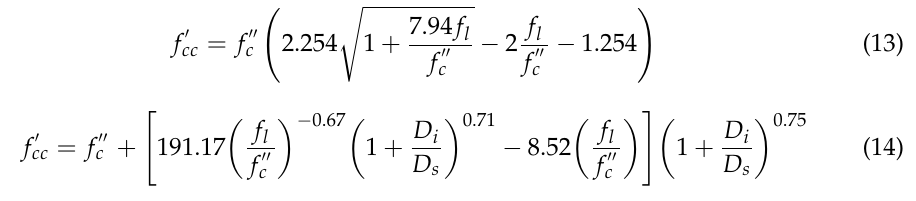
Figure 5. Model for the definition of tension stiffening of concrete. The confinement made by the FRP spirals provides enhancements in the compressive strength and deformation of concrete [85]. This enhancement is usually higher at ultimate than that at peak condition resulting in a hardening stress-strain behavior for sufficiently confined concrete [86–101]. As the final failure was due to ruptures in the longitudinal GFRP bars and crushing of the concrete core at mid-height without damage to the lateral spirals [5–7], the confinement strength model proposed by Mander et al. [92] (represented by Equation (13)) was, therefore, used to exactly capture the compressive strength of confined concrete core ( f cc’ ) obtained from the FE simulations. In case of exceeding the range of test parameters that were used to build Mander et al.’s [92] model, Equation (14) was herein introduced to have a different form. Finally, an excellent calibration between these two expressions is revealed by Figure